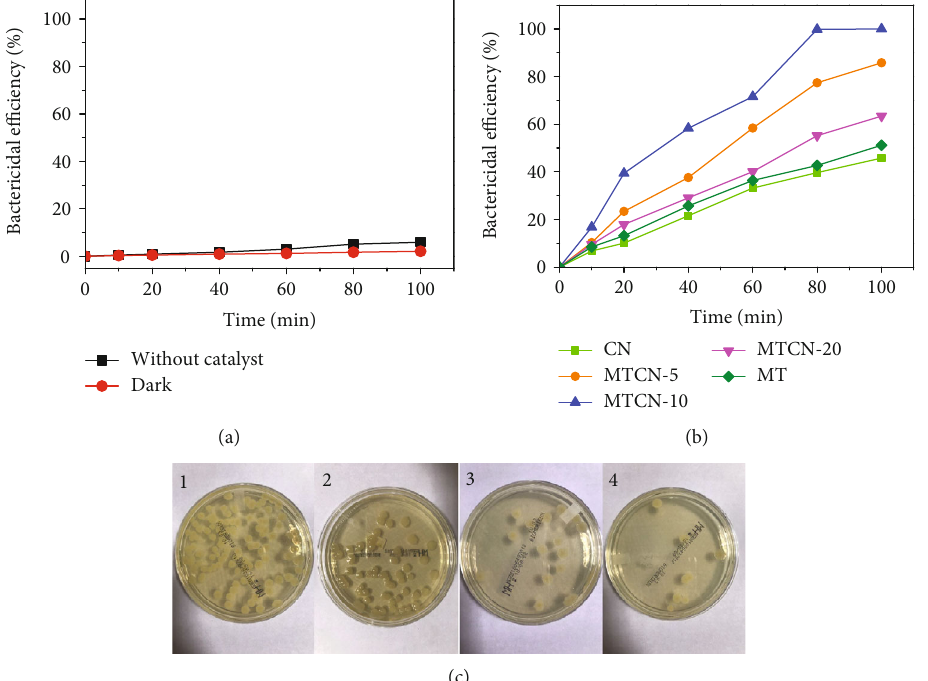
Figure 6: (a) Inactivation e ffi ciency against E. coli by photocatalyst in the dark and without photocatalyst under simulated solar light. (b) The inactivation of E. coli by as-prepared photocatalysts under simulated solar light. (c) Photographs of colonies formed by E. coli cells in water samples after treated by MT/CN-10 suspensions with simulated solar light for 0 (c1), 20 (c2), 60 (c3), and 80 (c4)